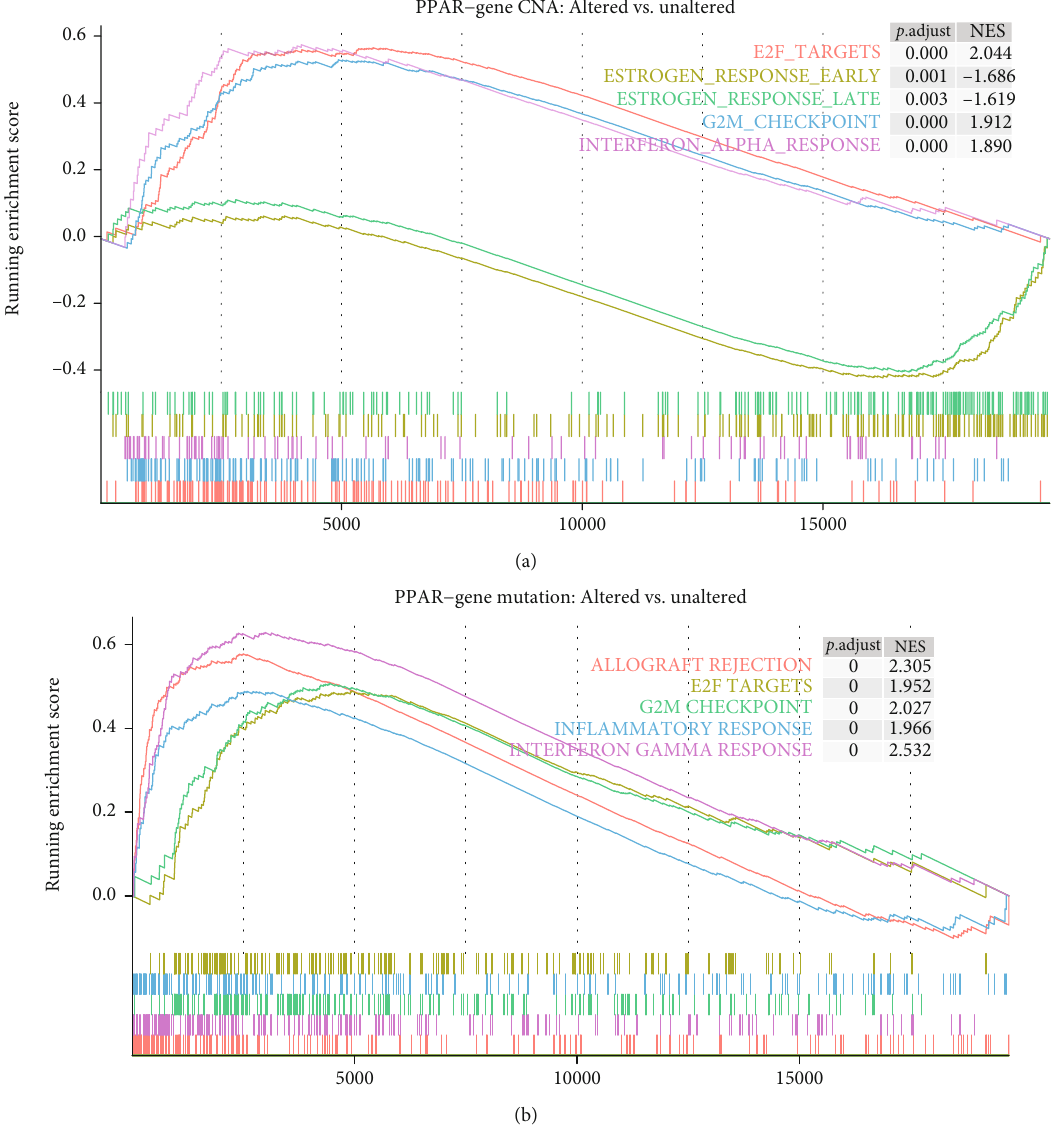
Figure 3: GSEA analysis between PPAR-related gene altered patients and unaltered patients. The fi ve most signi fi cantly changed pathways in the PPAR-related gene CNA patients (a) and the PPAR-related gene mutation patients (b). P .adjust: adjusted P value; NES: normalized enrichment predict the prognosis of UCEC patients based on the corre- lation coe ffi cient of each gene.